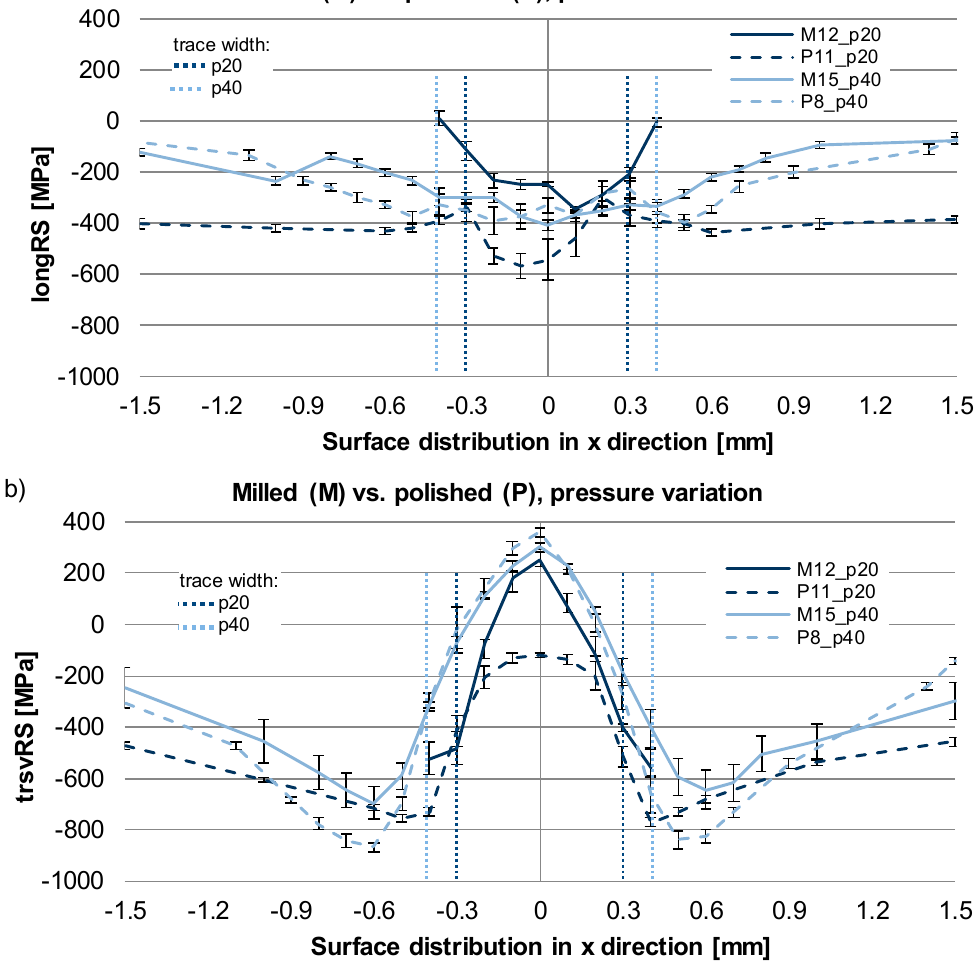
Figure 6. Residual stress surface distribution (measured with Seifert) after DR by different pre-machining states, i.e., milled and DR (designation “M”) or milled, polished and DR (designation “P”) and different DR pressure (designation “p”); ( a ) longitudinal residual stresses (longRS) and ( b ) transverse residual stresses (trsvRS).